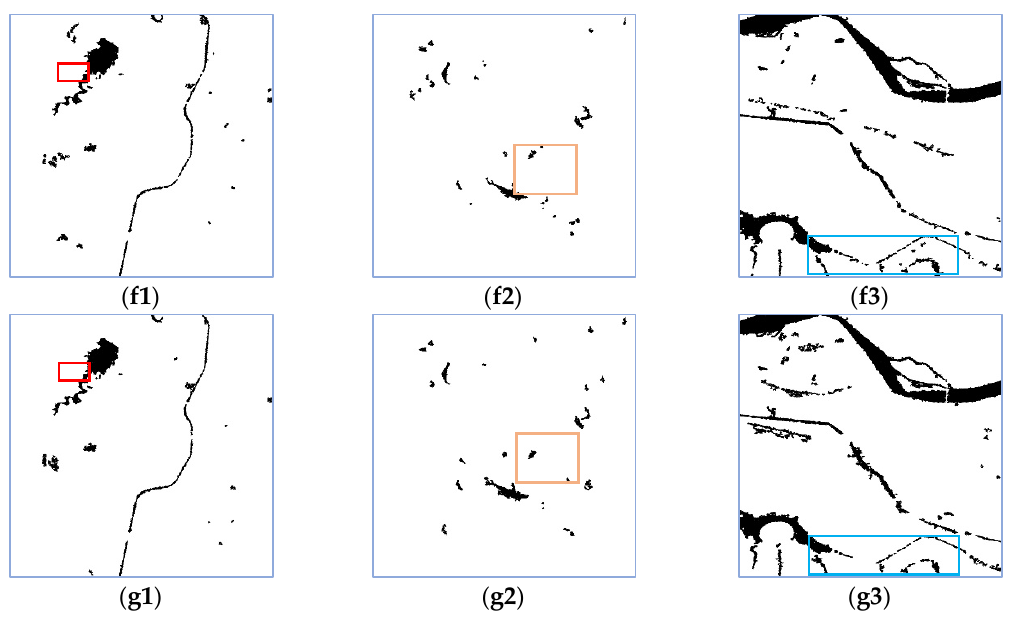
Figure 13. The extraction results of different methods. ( a1 )–( a3 ) FFEDN. ( b1 )–( b3 ) RF. ( c1 )–( c3 ) SVM. ( d1 )–( d3 ) U-Net. ( e1 )–( e3 ) U-Net-ResNet. ( f1 )–( f3 ) MSF-MLSAN. ( g1 )–( g3 ) WENET. Table 13. Quantitative evaluation of different models.